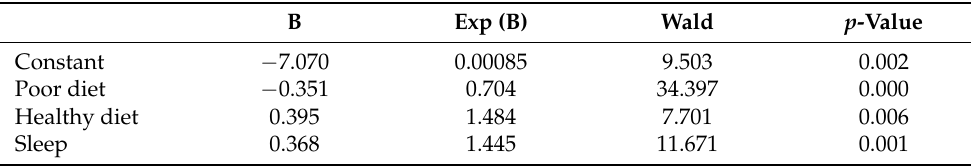
Table 5. Multiple Logistic Regression Results